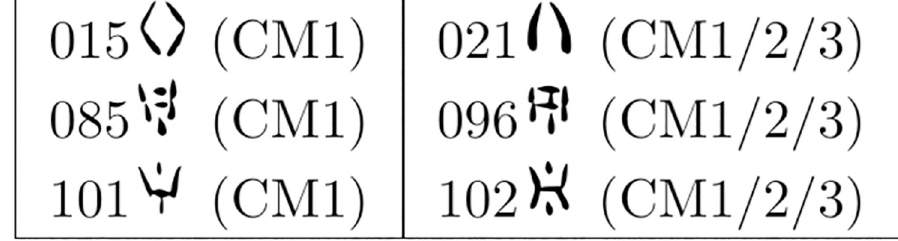
Fig 12. Pairs comprised of a shape attested only in CM1 (left column) and a shape attested in all sub-corpora (right column), hypothesized as variants of the same grapheme